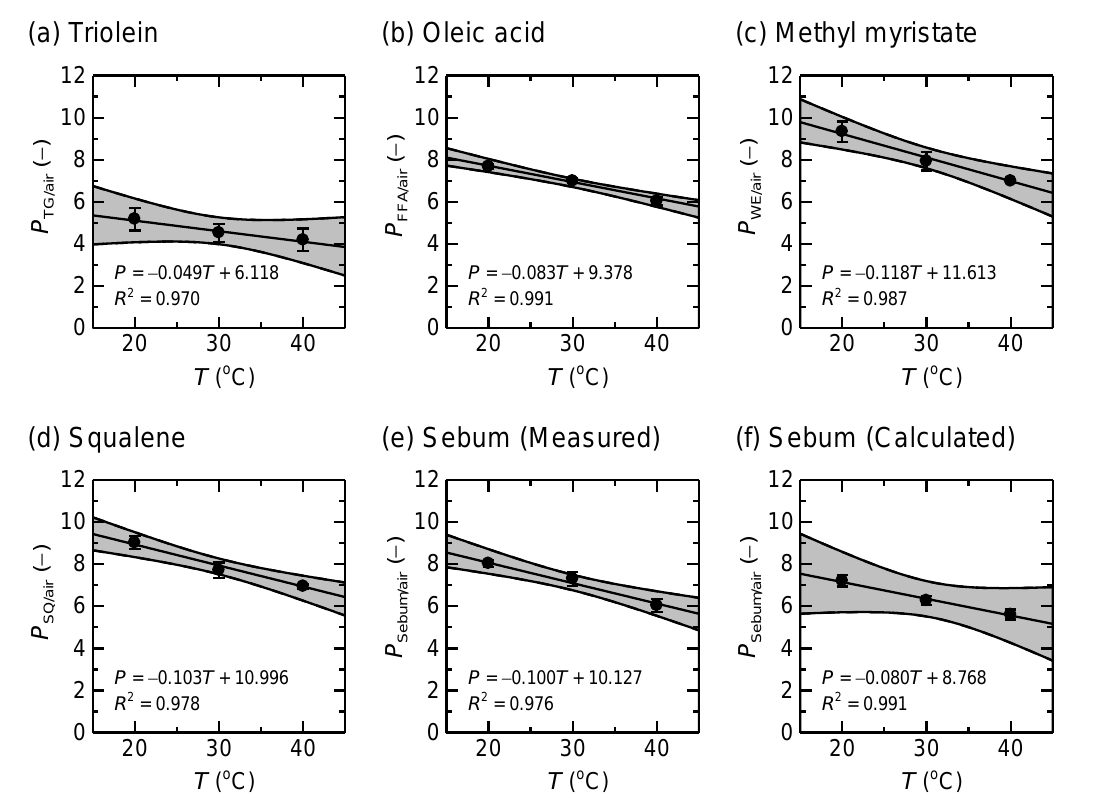
Figure 2. Partition coefficients of radon for sebaceous lipid samples as a function of temperature. Solid lines stand for the linear regression curves with 95% confidence intervals. The linear regression analysis was implemented for all individual data ( n = 3 at each temperature).